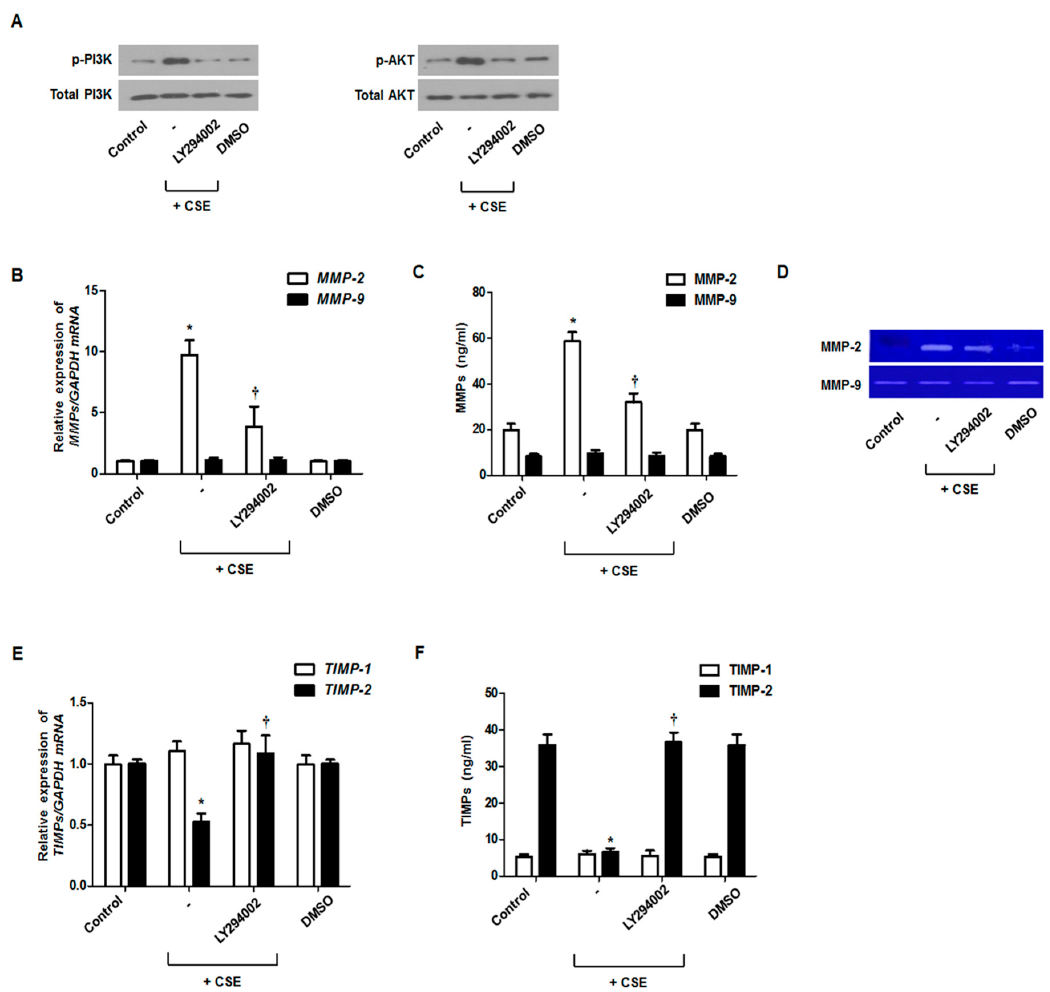
Figure 3. Regulation of PI3K / Akt signaling pathways with CSE regulated MMP and TIMP expression. Nasal fibroblasts were pretreated with LY294002 (PI3K / Akt inhibitor) before treatment with 5% CSE. Levels of phosphorylated (p)-PI3K and p-Akt were determined using western blotting ( A ). The expression levels of MMP and TIMP mRNAs were determined by real-time PCR ( B , E ). MMP and TIMP protein levels were determined using ELISA ( C , F ). The enzymatic activities of MMP-2 and MMP-9 were measured by gelatin zymography ( D ). * p < 0.05 vs. control; † p < 0.05 vs. CSE only.